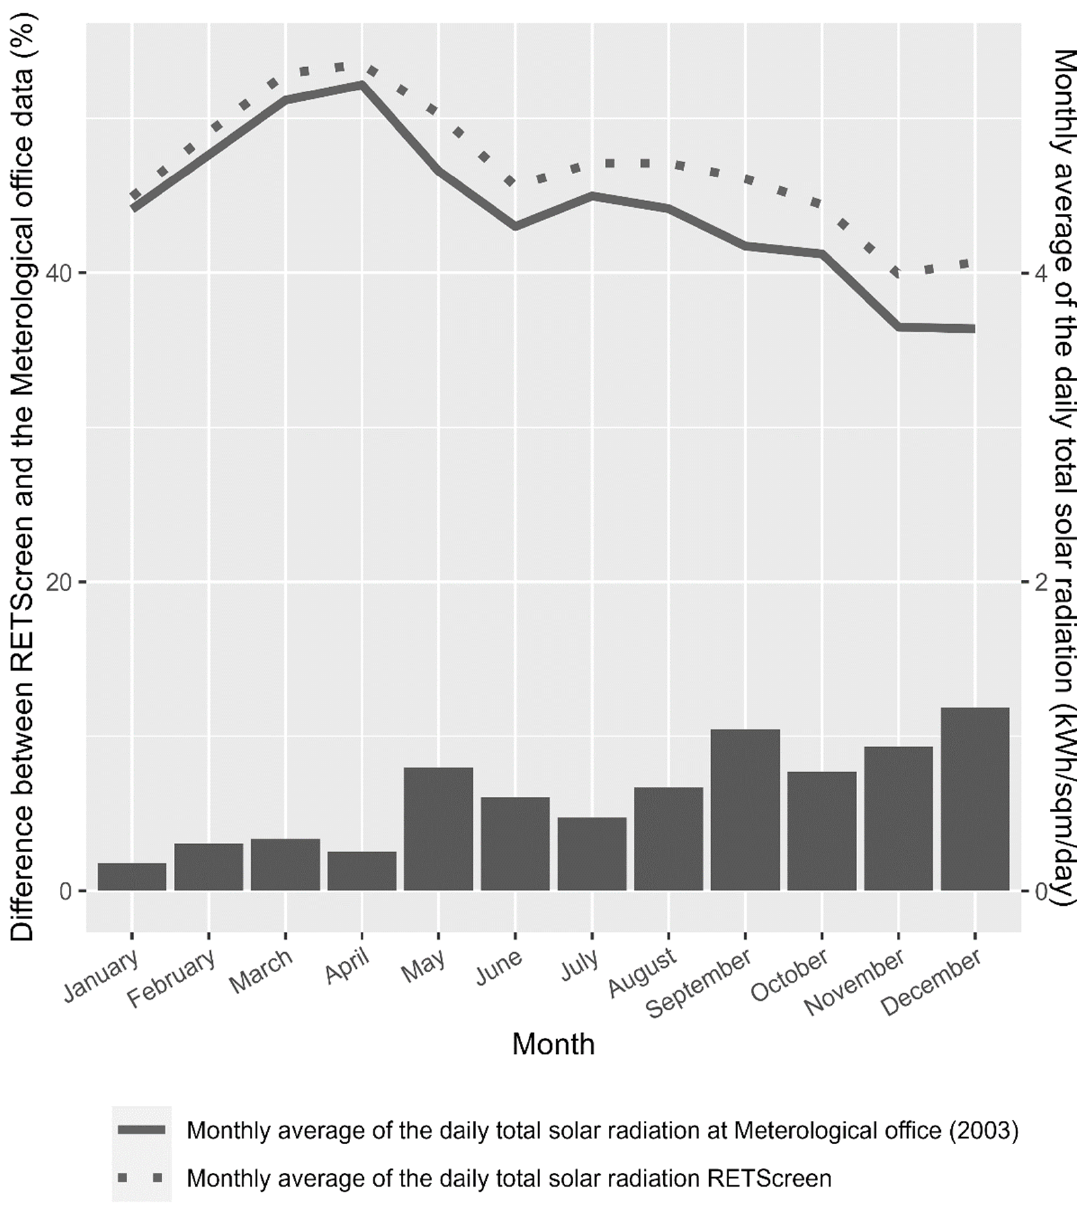
Figure 8. Data comparison between RETScreen’s ground-measured data and ground-measured data at Piarco obtained from the Trinidad and Tobago Meteorological Service in 2003.